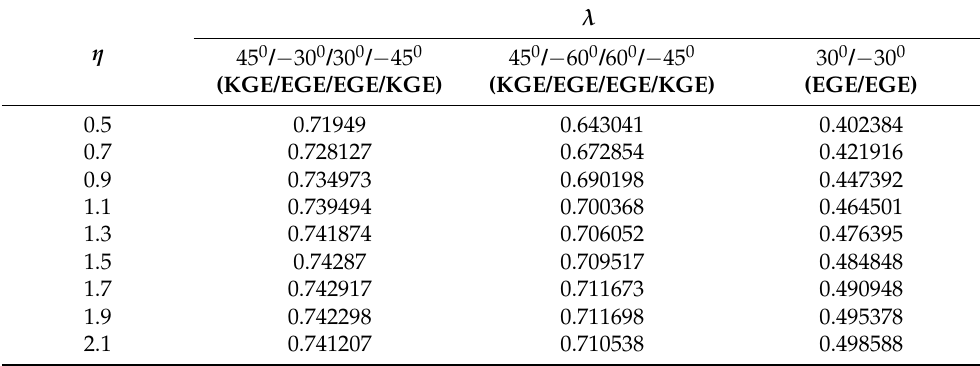
Table 2. Relation of linear thickness variation η and the fundamental frequency parameter λ . n = 2, γ = 0.05 and β =